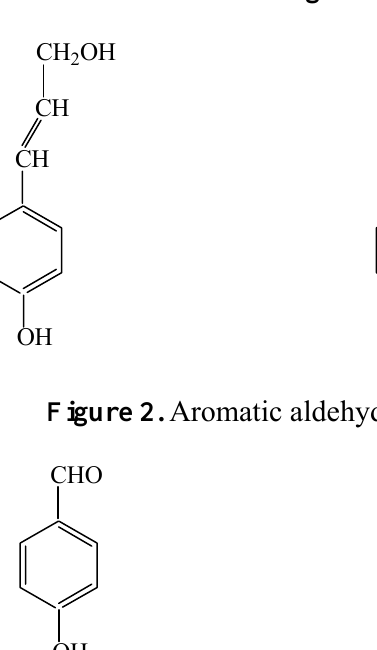
Figure 1. Lignin building units.